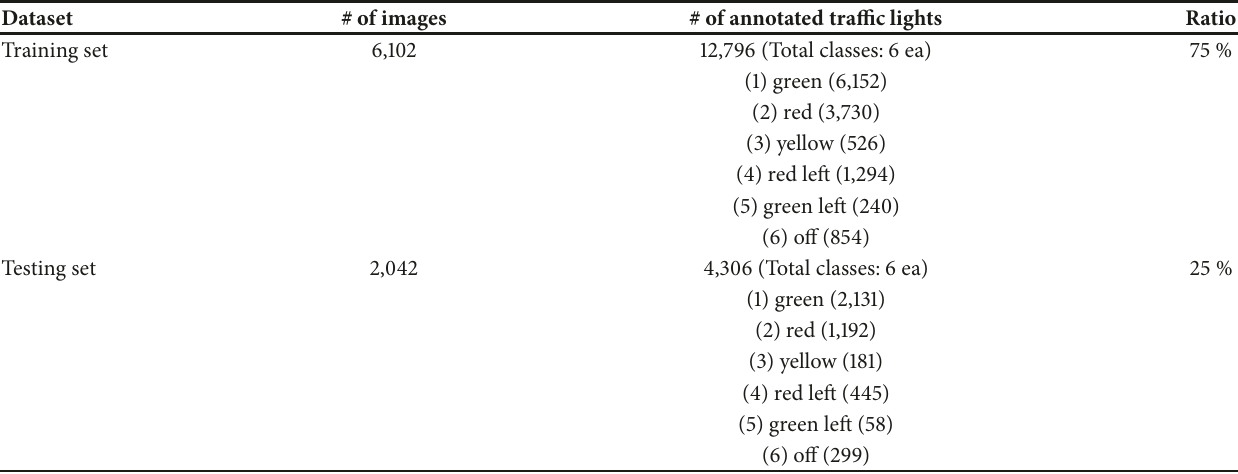
Table 3: Descriptions of training and testing sets.